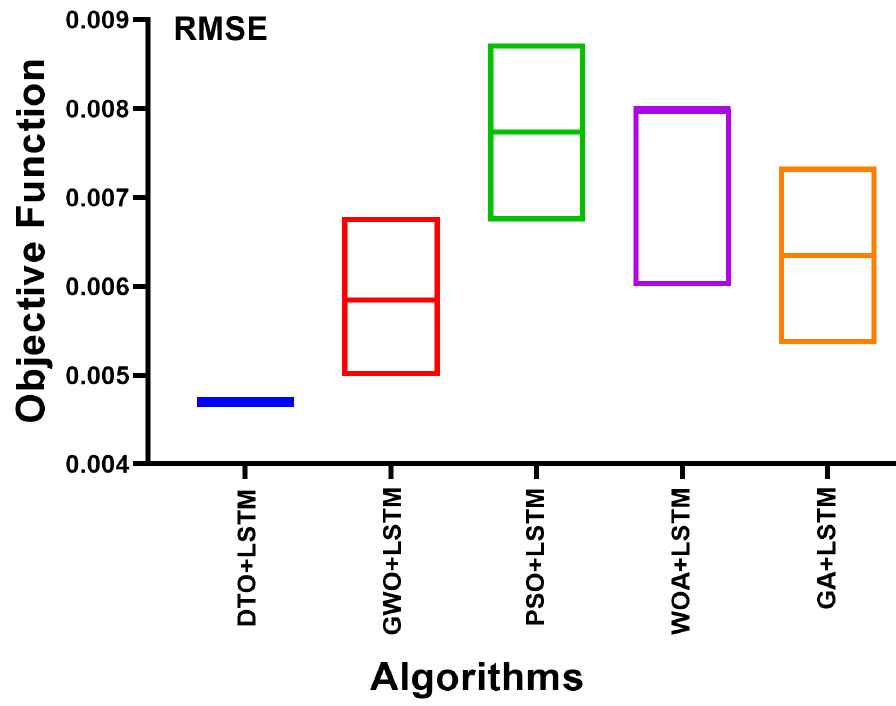
Figure 6. Visualizing the results of the ANOVA test.